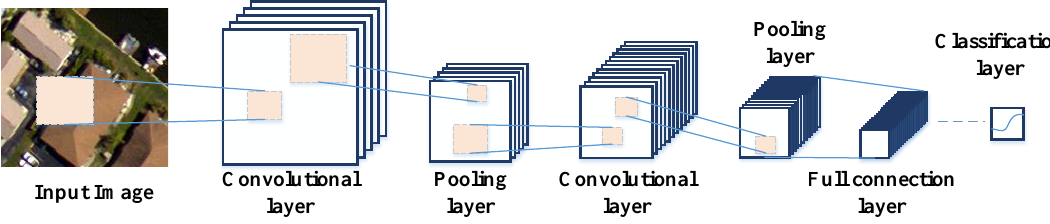
Figure 1. Typical CNN structure with seven